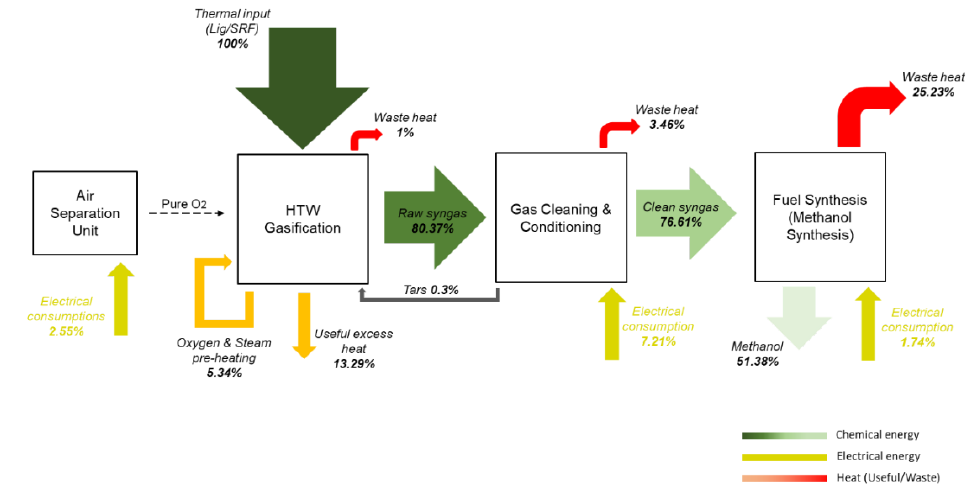
Figure 9. Heat balance of the process for case 2 (50/50 LEG/SRF feedstock).